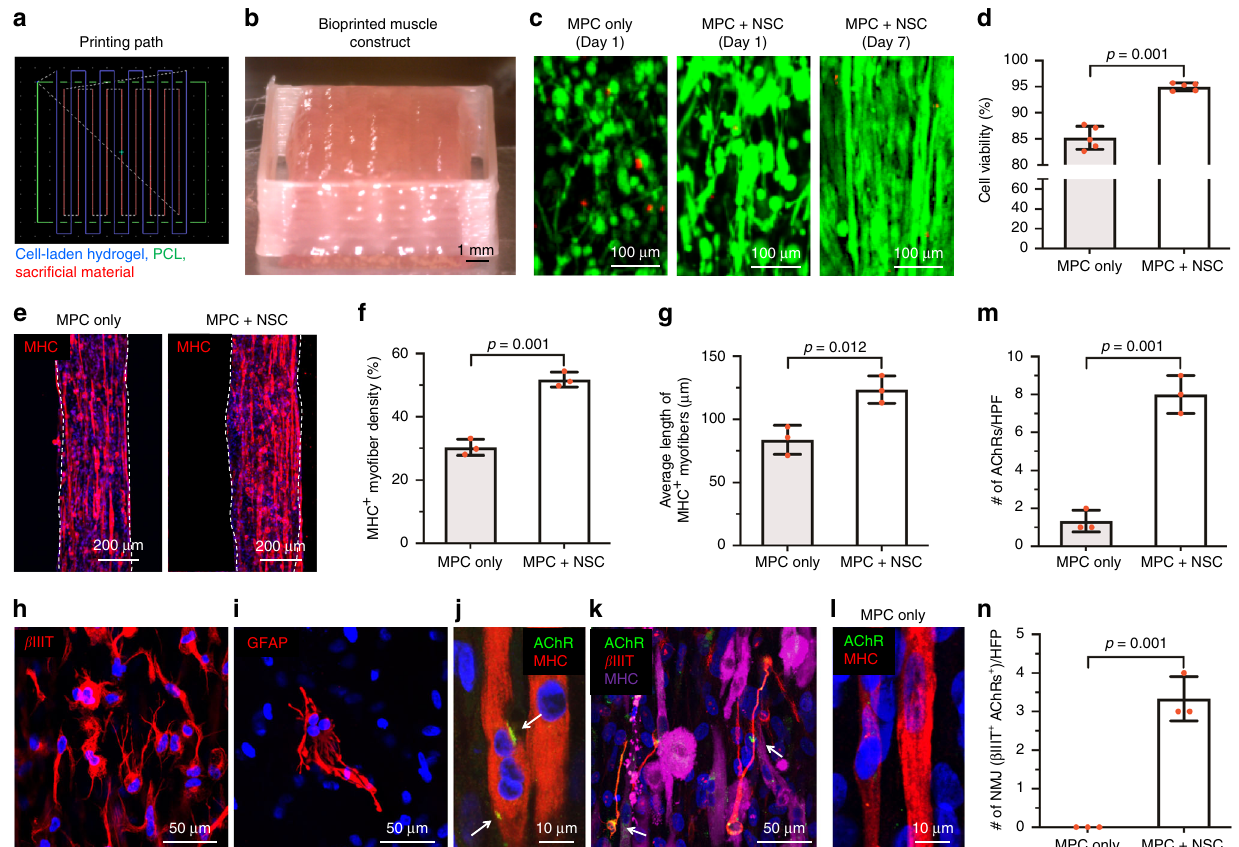
Fig. 3 In vitro evaluation of 3D bioprinted human skeletal muscle constructs. a Printing path for cell-laden hydrogel, PCL, and sacri fi cial material. b Bioprinted constructs containing hMPCs and hNSCs (30 × 10 6 cells per ml, 10 × 10 × 3 mm 3 in dimension) after printing. c Live/dead staining images of the central part of bioprinted constructs containing MPC only and MPC + NSC (300:1) at 1 and 7 days. d Quantitative cell viability (%) at 1 day after printing ( n = 5 per group). e Immuno fl uorescence for MHC (red) of MPC only and MPC + NSC. Quantitative analysis of f MHC + myo fi ber density (%) ( n = 3 per group) and g average length of MHC + myo fi bers ( µ m) at 7 days ( n = 3 per group, two-sided Student ’ s t -test, * p = 0.012). h , i Immuno fl uorescence for (H) β IIIT (red) of differentiated neurons and (I) GFAP (red) of glial cells. The experimental fi ndings were qualitatively reproduced three times. j , k Immuno fl uorescence for j AChR (green)/MHC (red) of AChRs pre-patterning on myotubes (white arrows) and k AChR (green)/ β IIIT (red)/MHC (purple) of NMJs (white arrows). l Immuno fl uorescence for AChR (green)/MHC (red) of MPC only construct. m Number of AChRs per fi eld ( n = 3 per group). n Number of β IIIT + AChR + NMJs per fi eld ( n = 3 per group). All data are represented as mean ± SD. The p -values by two-sided Student t -test are indicated.